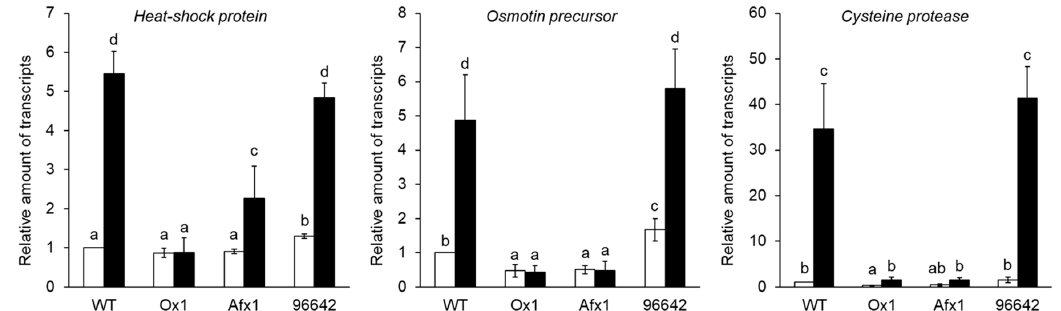
Figure 3. Expression of senescence-associated genes in flooded and unflooded (control) nodules. For each line, the mRNA levels in unflooded WT nodules were set at 1. Values are means ± SE of three biological replicates, each with three technical replicates. Open bars, unflooded; filled bars, flooded. Means denoted by the same letter do not differ significantly by Student’s t -test at p < 0.05.